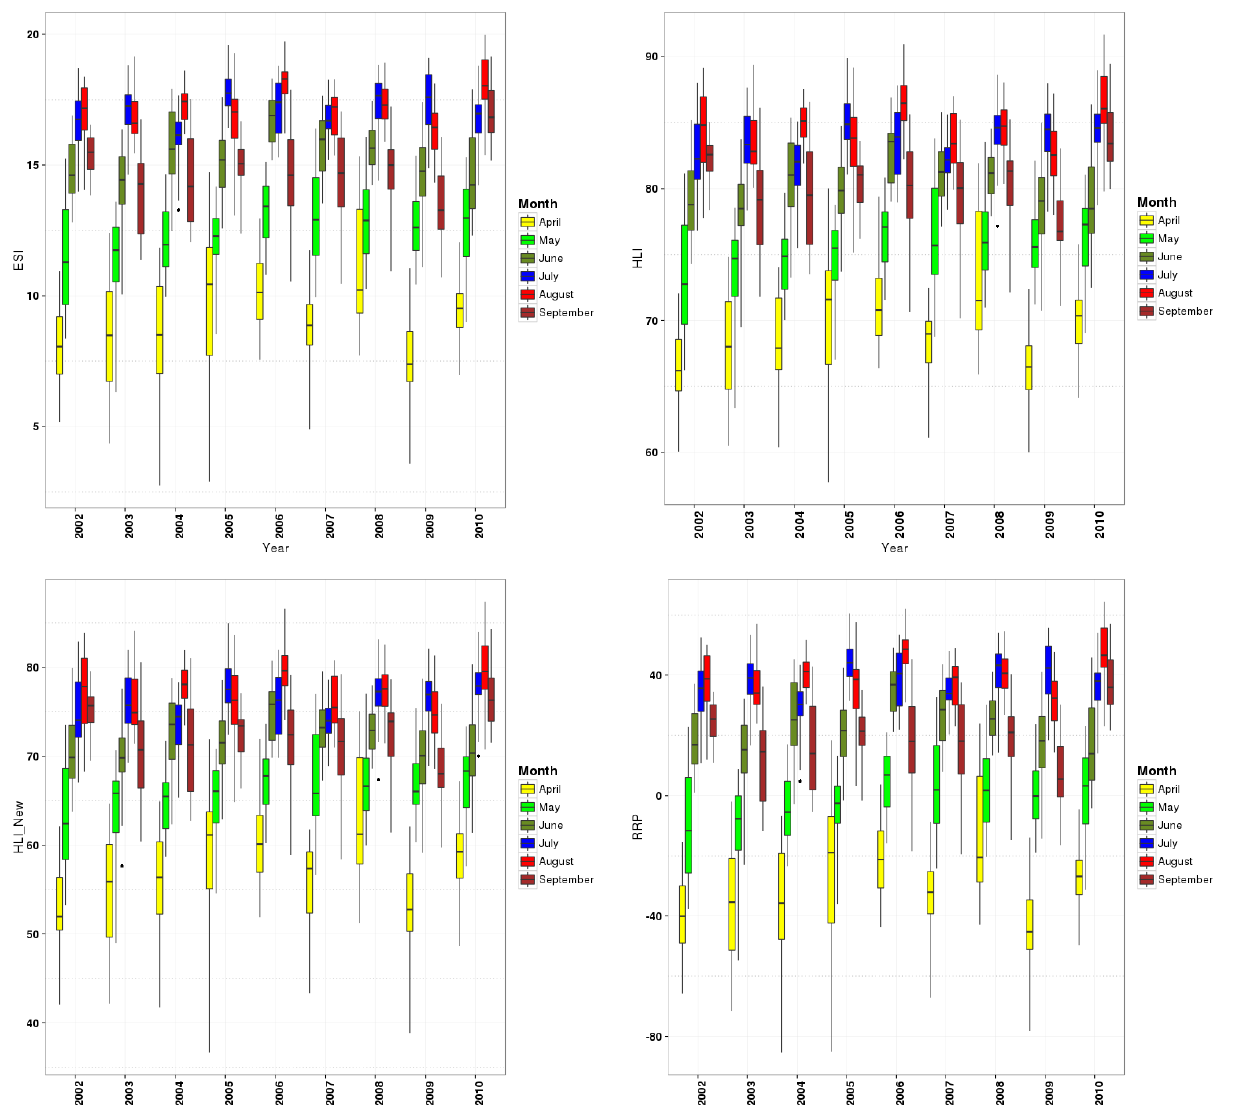
Figure 4. The box plots of ESI, HLI, HLI New , and RRP from 2002 to 2010 in the spring and